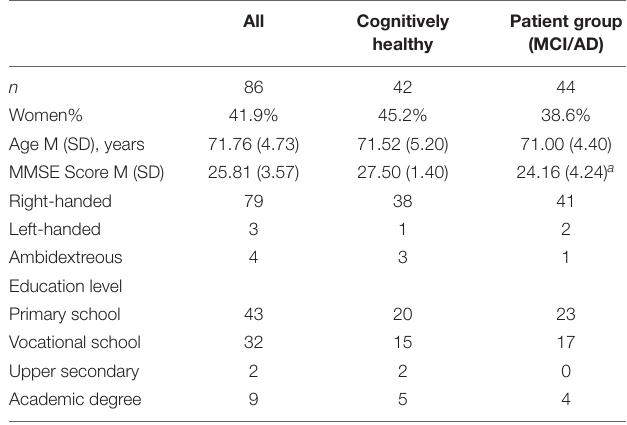
TABLE 1 | Demographic and clinical characteristics of study participants.